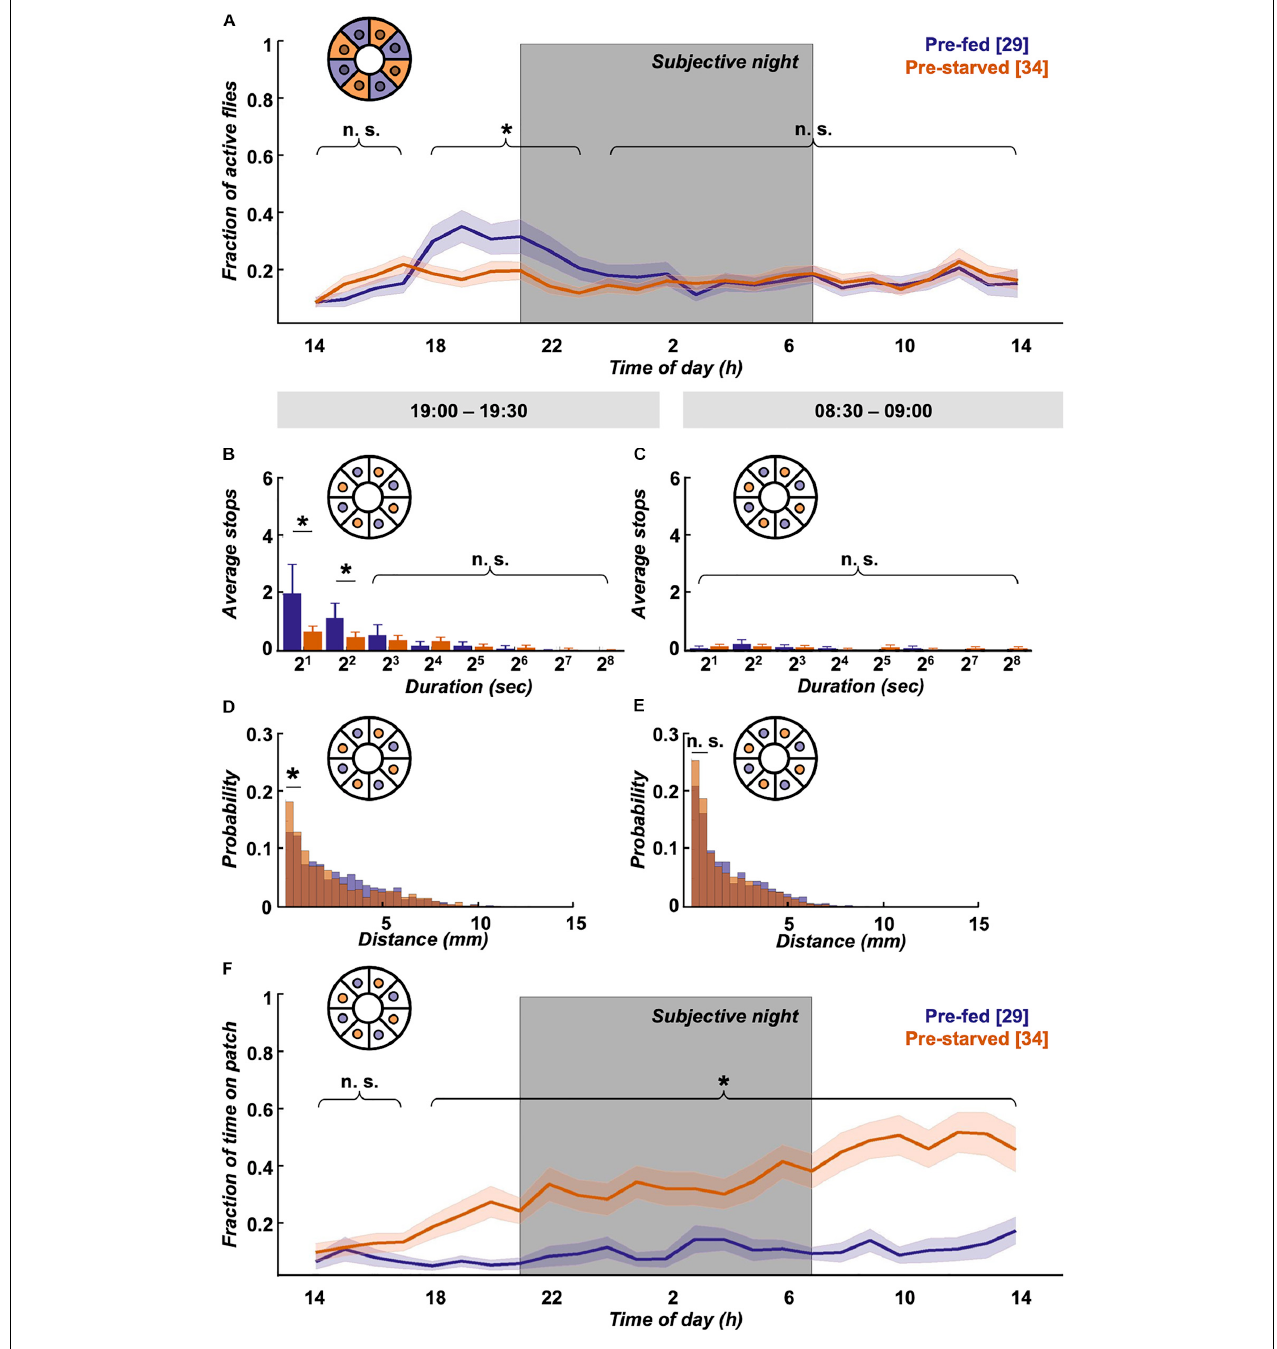
FIGURE 4 | Locomotion activity and food patch preference over 24 h on food patch assay. (A) Although initial activity levels on the food patch arena (inset schematic) are comparable, pre-starved flies (orange, n = 34) continued to show significantly decreased activity levels during subjective evening and early night, as compared to pre-fed flies (deep purple, n = 29). Subjective night indicated by grey-shaded area. There was no significant difference in activity across the rest of the 24 h. (B) Pre-fed flies showed significantly increased numbers of stops of shorter duration (2–7 s) on the food patch (inset schematic) than pre-starved flies during peak activity time window of 19:00–19:30, (C) whereas no significant difference in food patch stops was observed between 08:30 and 09:00 the next morning between the two groups. X -axis tick labels indicate duration of stops with a log 2 scale, where 2 1 = 2–3 s, 2 2 = 4–7 s, and so on. (D) Short-distance moves ( ≤ 2 mm) between both groups were significantly different on the food patch (inset schematic) during the 19:00–19:30 time window, (E) but not during the 08:30–09:00 time window. (F) Pre-starved flies spent significantly higher fractions of time on the food patch (inset schematic) as compared to pre-fed flies, with exception of the initial 3 h. *Indicate significance levels following Mann–Whitney U-tests (alpha = 0.05), n.s. = not significant. Horizontal lines indicate significance levels between pre-fed and pre-starved flies from a single group. Curly braces represent identical significance levels between pre-fed and pre-starved from multiple groups. N values are given in